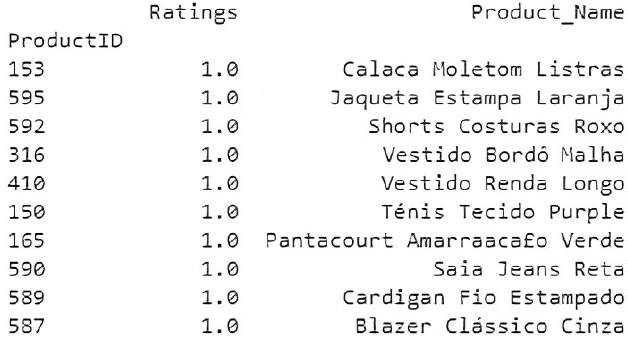
Figure 12. Ten reviews of products given by the